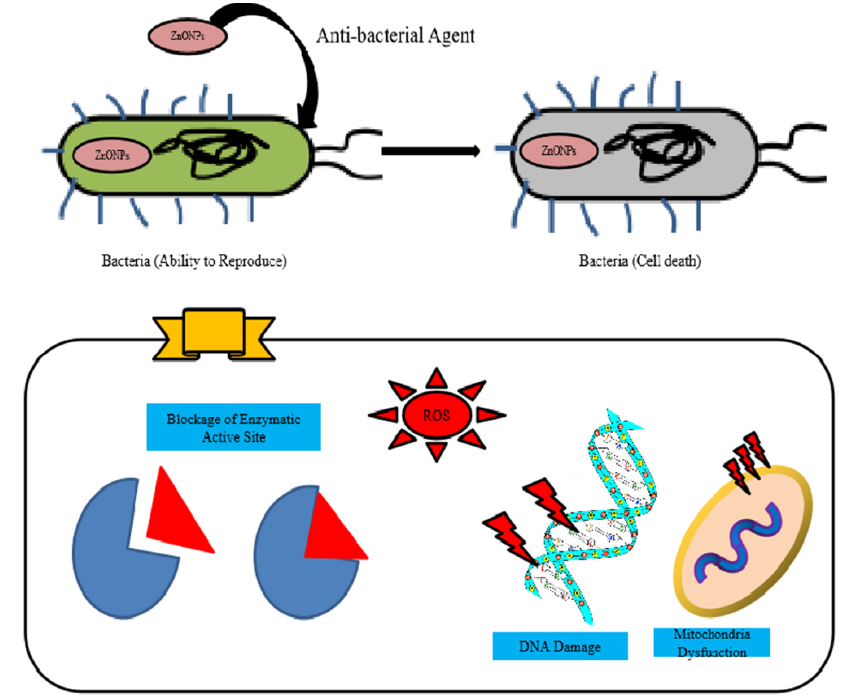
Figure 4. Antibacterial activity of ZnO nanoparticles. Upon attachment and entry to bacterial cell there are three possible ways through which bacterial cells are killed. ZnO nanoparticles either block the electron transport chain which results in low production of ATP, or they interact with various enzymes, resulting in enzyme alteration due to which the substrate cannot bind to enzyme, hence resulting in low concentration of product. Thirdly, they produce reactive oxygen species (ROS) which cause oxidative damage to different biomolecules such as DNA, proteins, and lipids, resulting in altered cellular machinery.